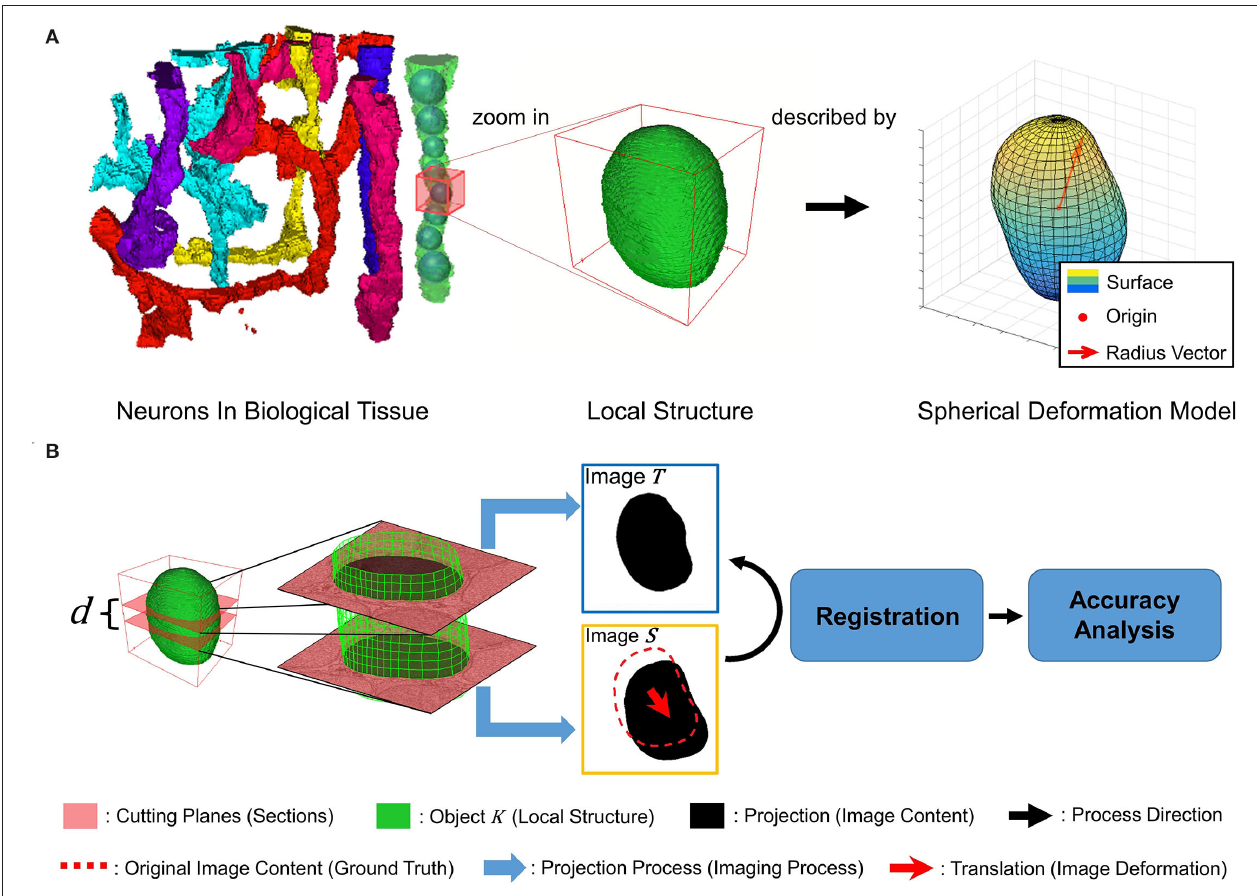
FIGURE 1 | (A) A tubular-like neuron is modeled as a sequence of local sphere-like structures described by a spherical deformation model with different parameters. (B) Illustration of simulated imaging, image deformation, registration, and accuracy analysis process.